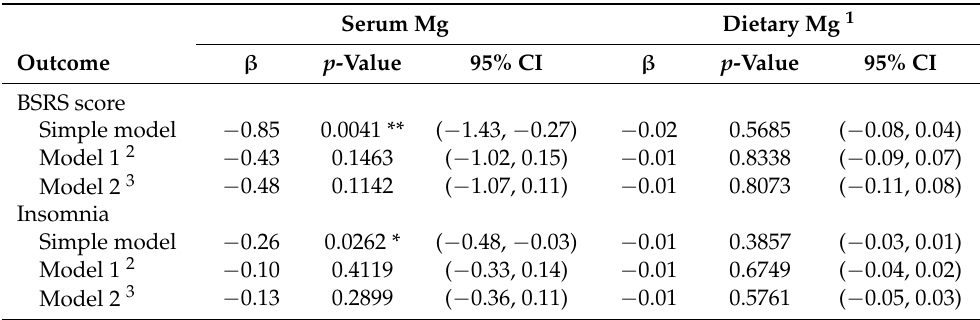
Table 2. Simple and multiple linear regression analysis of BSRS-5 outcome measures versus predictor variables (dietary or serum